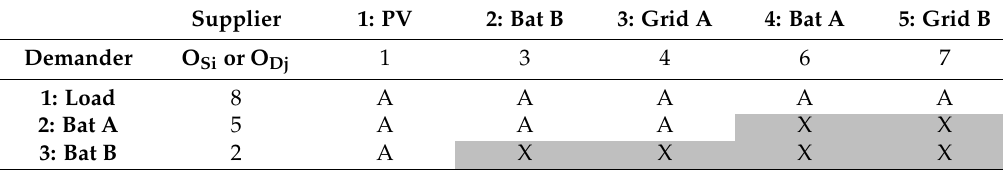
Table 1. Suppliers and demanders priorities and allowed